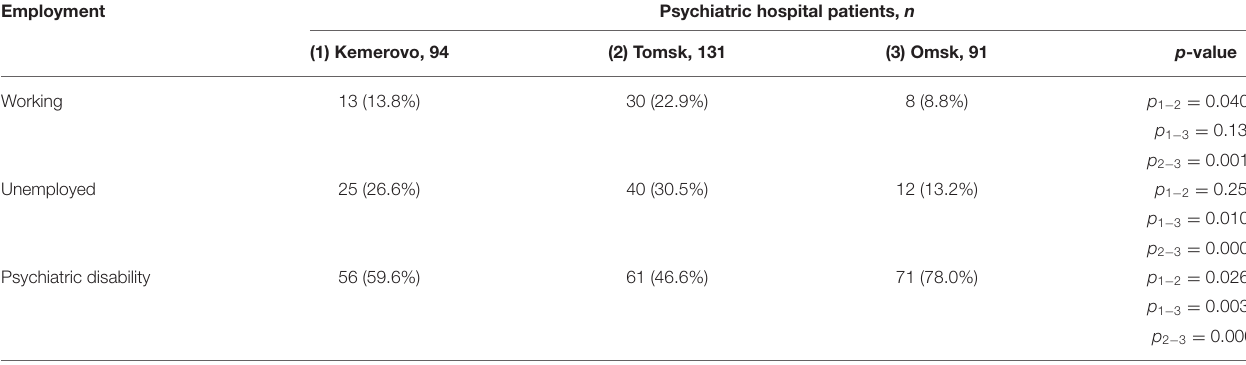
TABLE 2 | Employment status of the study population, n (%).